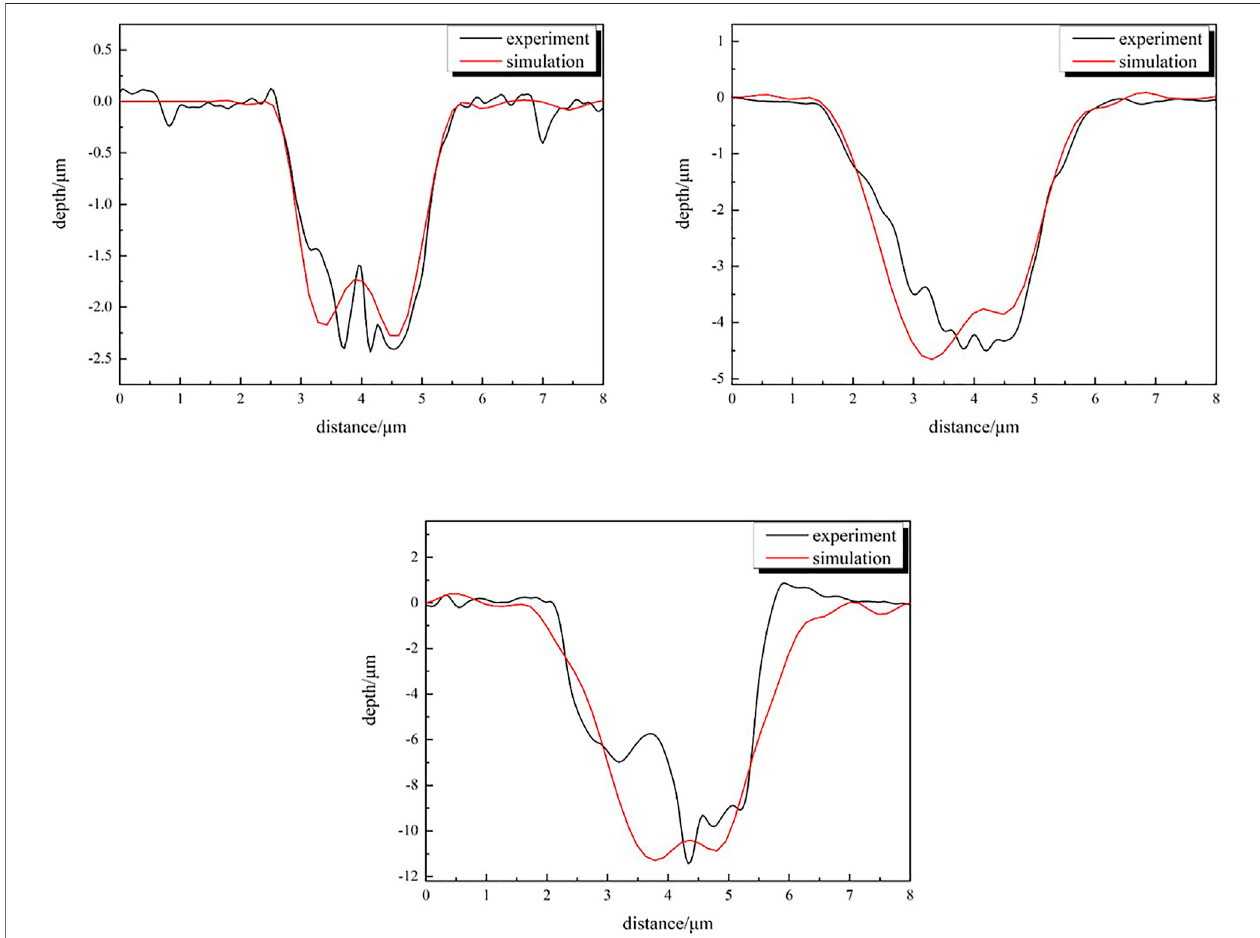
FIGURE 16 | Comparison of CA simulation and actual corrosion morphology at different times. (A) 30 days, (B) 60 days, (C) 180 days.